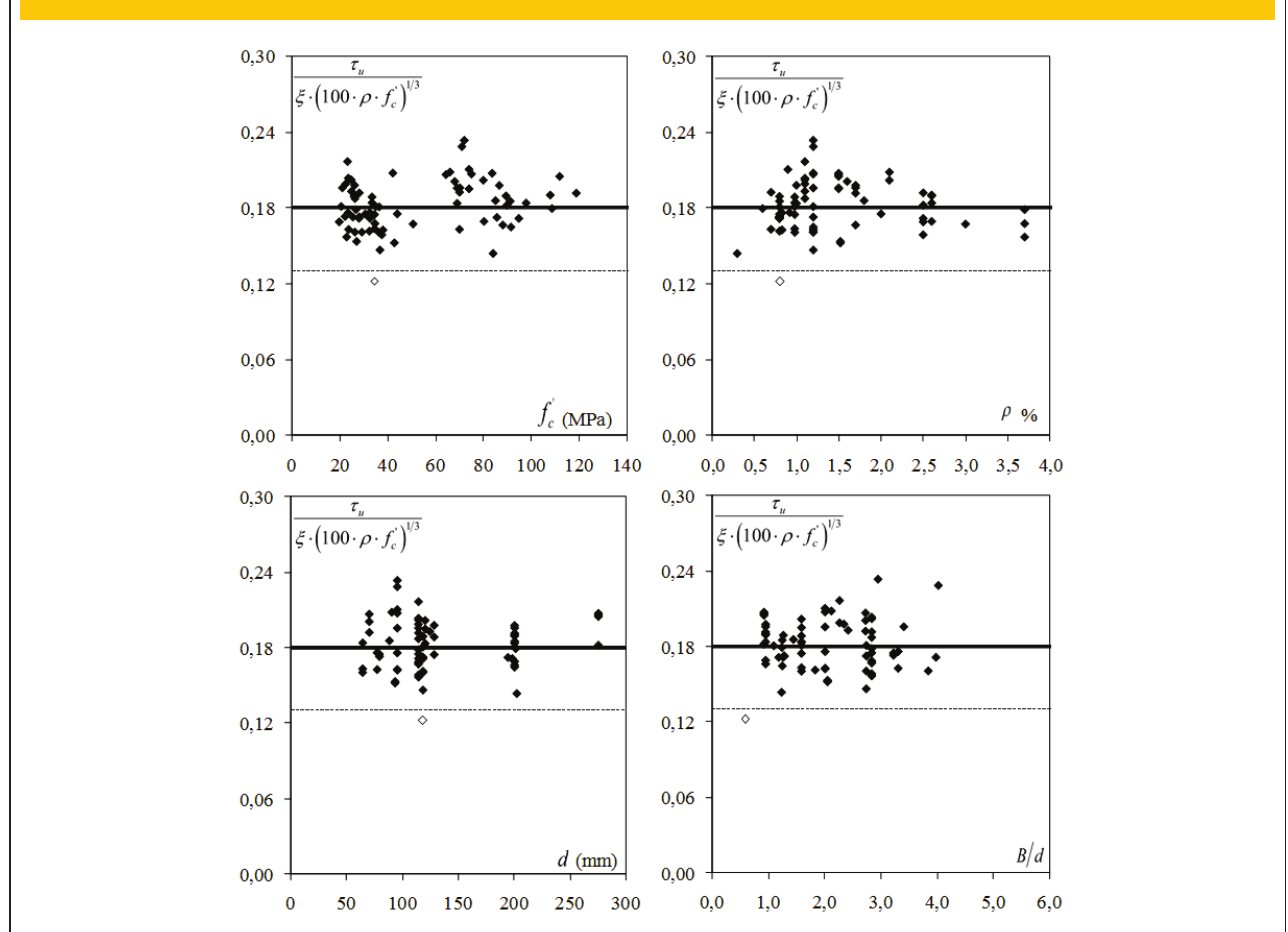
Figure 1� � �om�arison of results from database with those using recommendations of NBR 6118